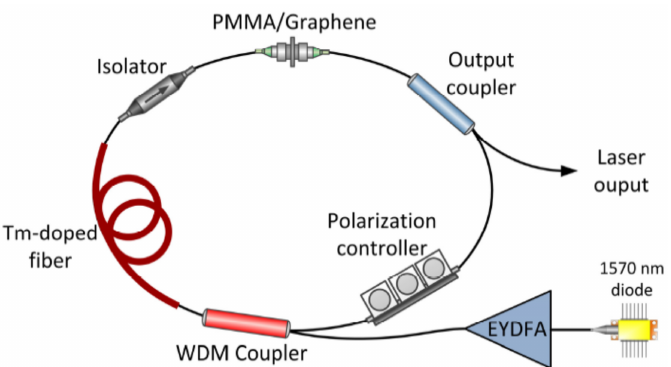
Figure 18. Tm-doped fiber laser system incorporated with a sandwiched graphene SA module. Reprinted with permission from [79].